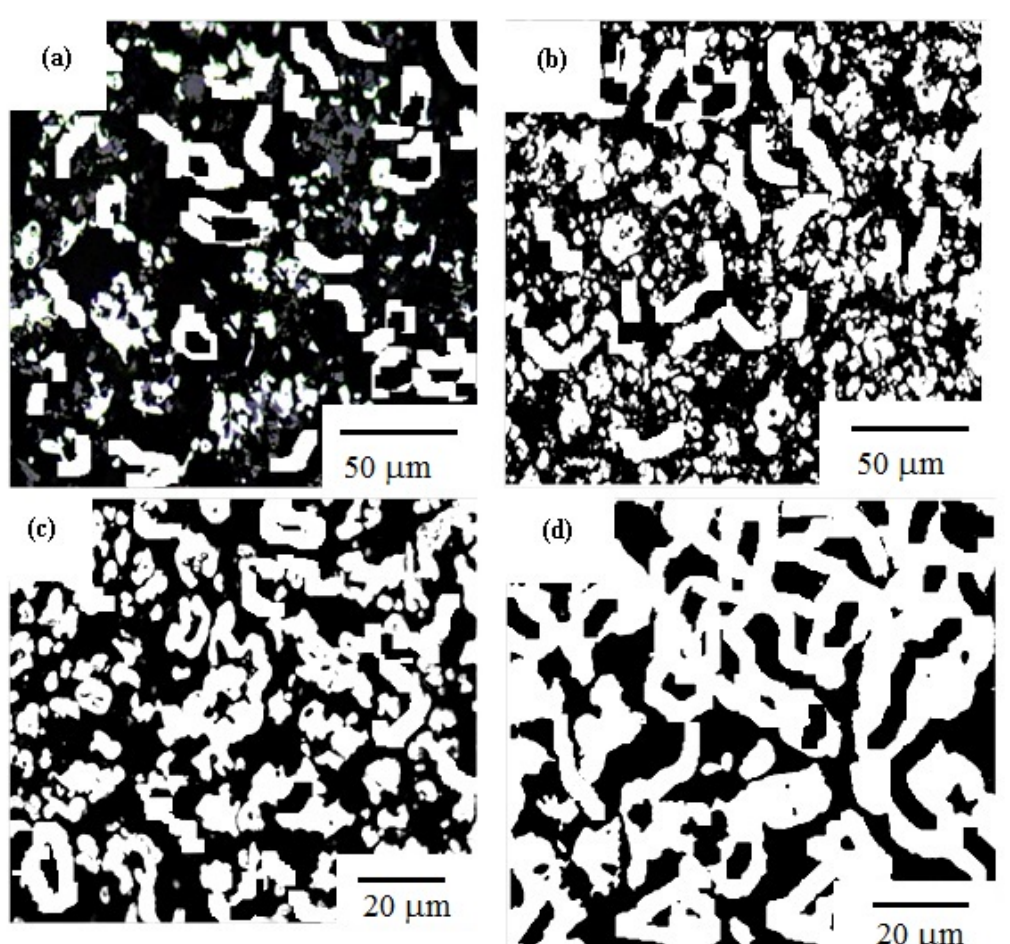
Figure 17. RLM photomicrograph of iron ore-coal composite reduced up to 1100 °C at different heating rates: ( a ) 20 °C/min, ( b ) 10 °C/min, ( c ) 15 °C/min and ( d ) 5 °C/min.